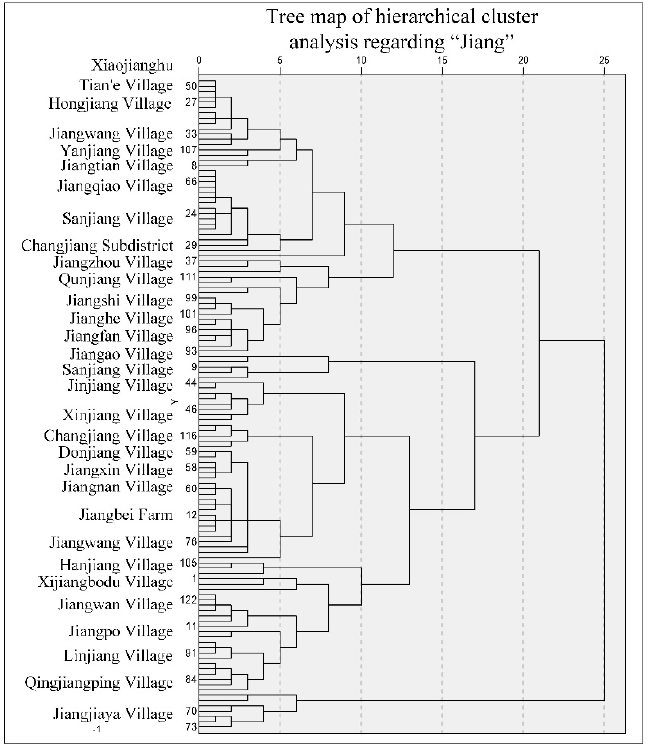
Figure 6. Tree diagram of hierarchical clustering for “Jiang”.